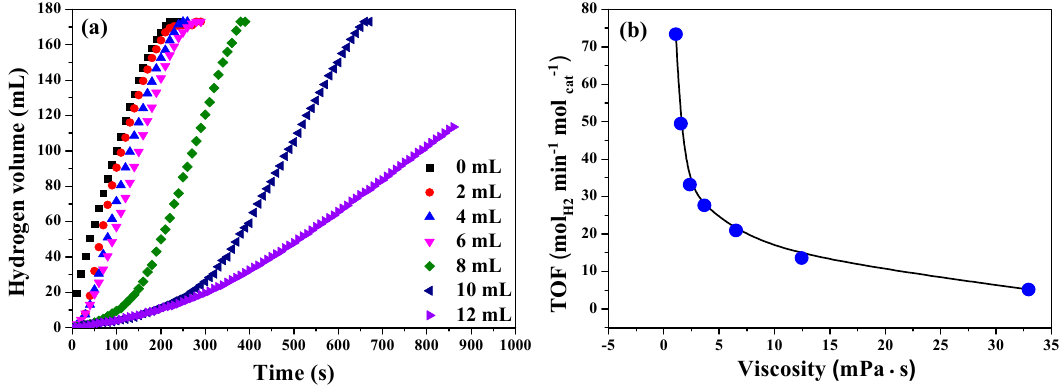
Figure 6. Hydrogen release curves in mixed solvent with different volume of glycerol. The total volume of water and glycerol before mixing is fixed at 20 mL. Table 1. Data of viscosity of reaction medium and the corresponding TOF values and induction times. Volume of Glycerol